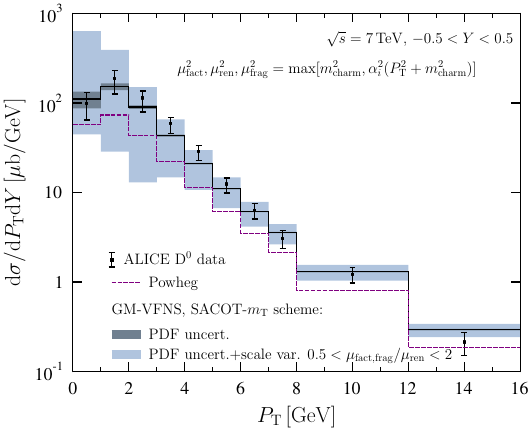
p Figure 10 . A comparison of the ALICE s = 7 TeV (D 0 + D 0 ) = 2 data [62] with the GM-VFNS and Powheg calculations. The black lines indicate the central GM-VFNS results, the PDF uncer- tainty is shown as darker band, and the light-blue band is the PDF uncertainty and scale variation added in quadrature. The purple dashed line is the central result from Powheg calculation. The experimental 3.5% luminosity and 1.3% global uncertainty on D 0 ! K (cid:0) (cid:25) + branching ratio are not shown.